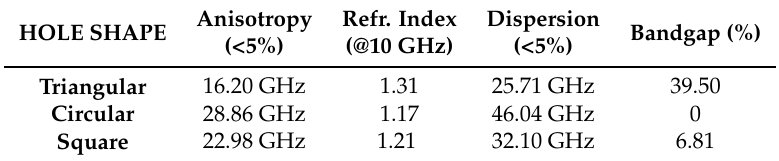
Table 1. Comparison among different metastructures possessing glide symmetry for the maximum hole size. For each line, the frequency values in the columns “Anisotropy” and “Dispersion” correspond to the maximum frequency that shows a deviation less than 5% with respect to the value at f = 0. The geometrical parameters of the unit cells are: h hole = 1.5mm, g = 0.2mm, and d x = d y =